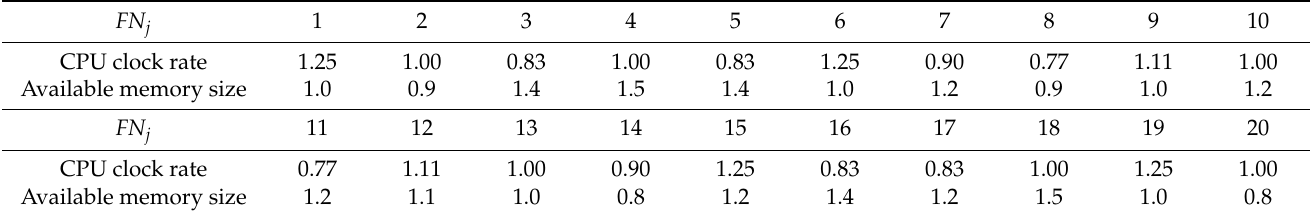
Figure 3. Comparison of weight adaptive adjustment times of M-E-AWA and MOEA/D-AWA algorithms when the maximum number of iterations is 15,000. Table 9. The j -th column represents the data information when the number of fog nodes is j